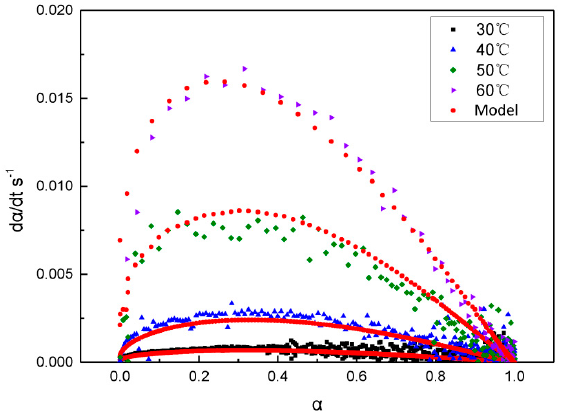
Figure 6. The curing rate ( d α / dt )—conversion rate ( α ) curve of GAPSPs and its fitting curve.